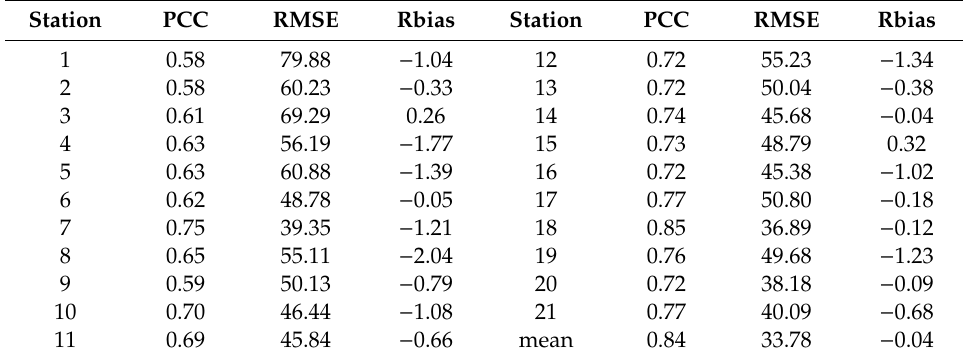
Table 7. Results of support vector regression (SVR) and quantile mapping (SVR_QM) models for each station and the region mean.